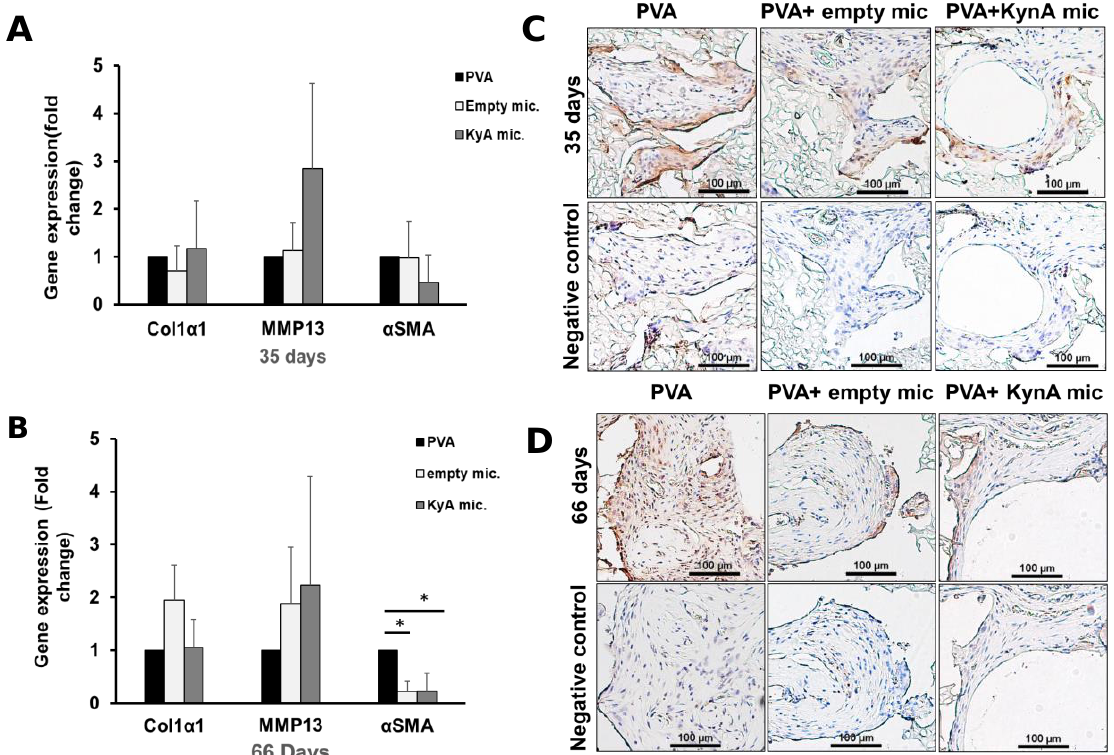
Figure 6. Expression of ECM components in tissue grown inside PVA sponges. ( A , B ) The levels of expression of Col1 α 1, MMP-13, and α -SMA genes in tissue grown inside PVA sponges of three groups: (i) PVA alone, (ii) PVA +empty microspheres, and (iii) PVA + KynA microspheres analyzed by qPCR at day 35 ( A ) and 66 ( B ). The results were normalized to β -actin as an internal control. Data represent as fold change relative to PVA alone group (mean ± SD, n = 3, * statistical significance, p = 0.009). ( C , D ) Immunohistochemical staining of skin samples from PVA alone, PVA + empty microspheres, and PVA + KynA microspheres groups for α -SMA. Cells expressing α -SMA in tissue grown inside PVA sponges at 35 ( C ) and 66 days ( D ), scale bar: 100 µ